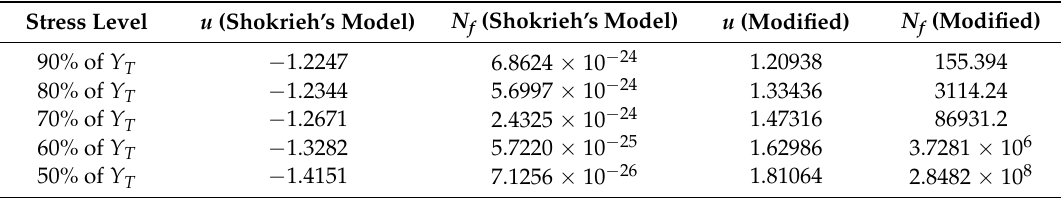
Table 1. A comparison to the values of the unified load parameters.